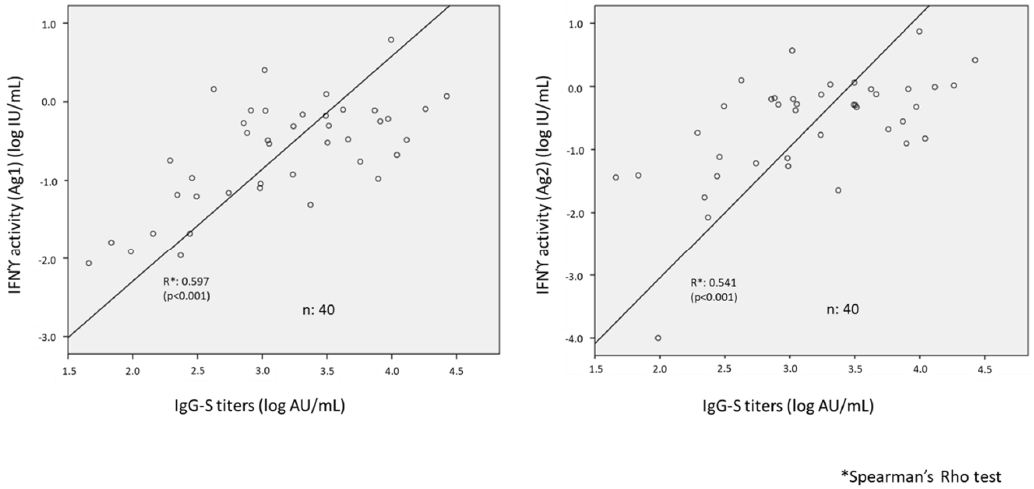
Figure 2. Association between humoral (IgG to spike titers) and cellular (IFN γ production) response after mRNA SARS-CoV-2 vaccination.